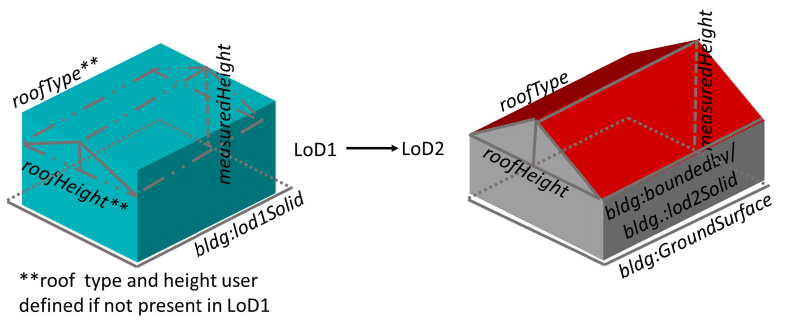
Figure 6. An overview of upscaling LoD1 models to